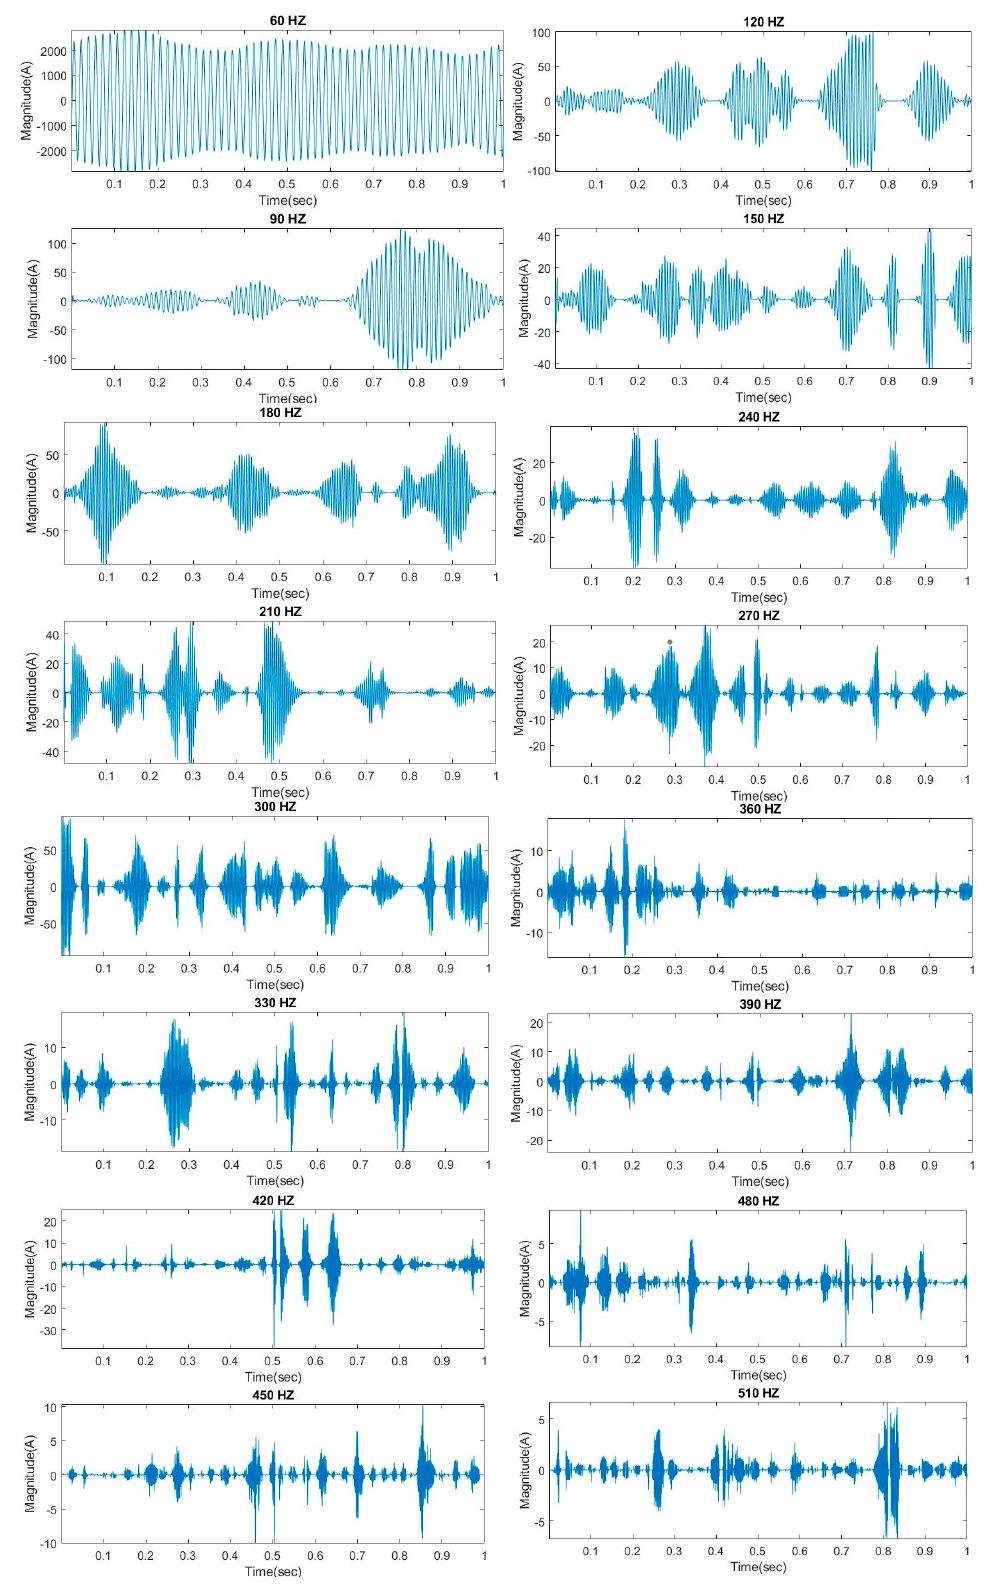
Figure 11. EAF case: selected reconstructed time-domain waveforms up to 510 HZ corresponding to Figure 10b.